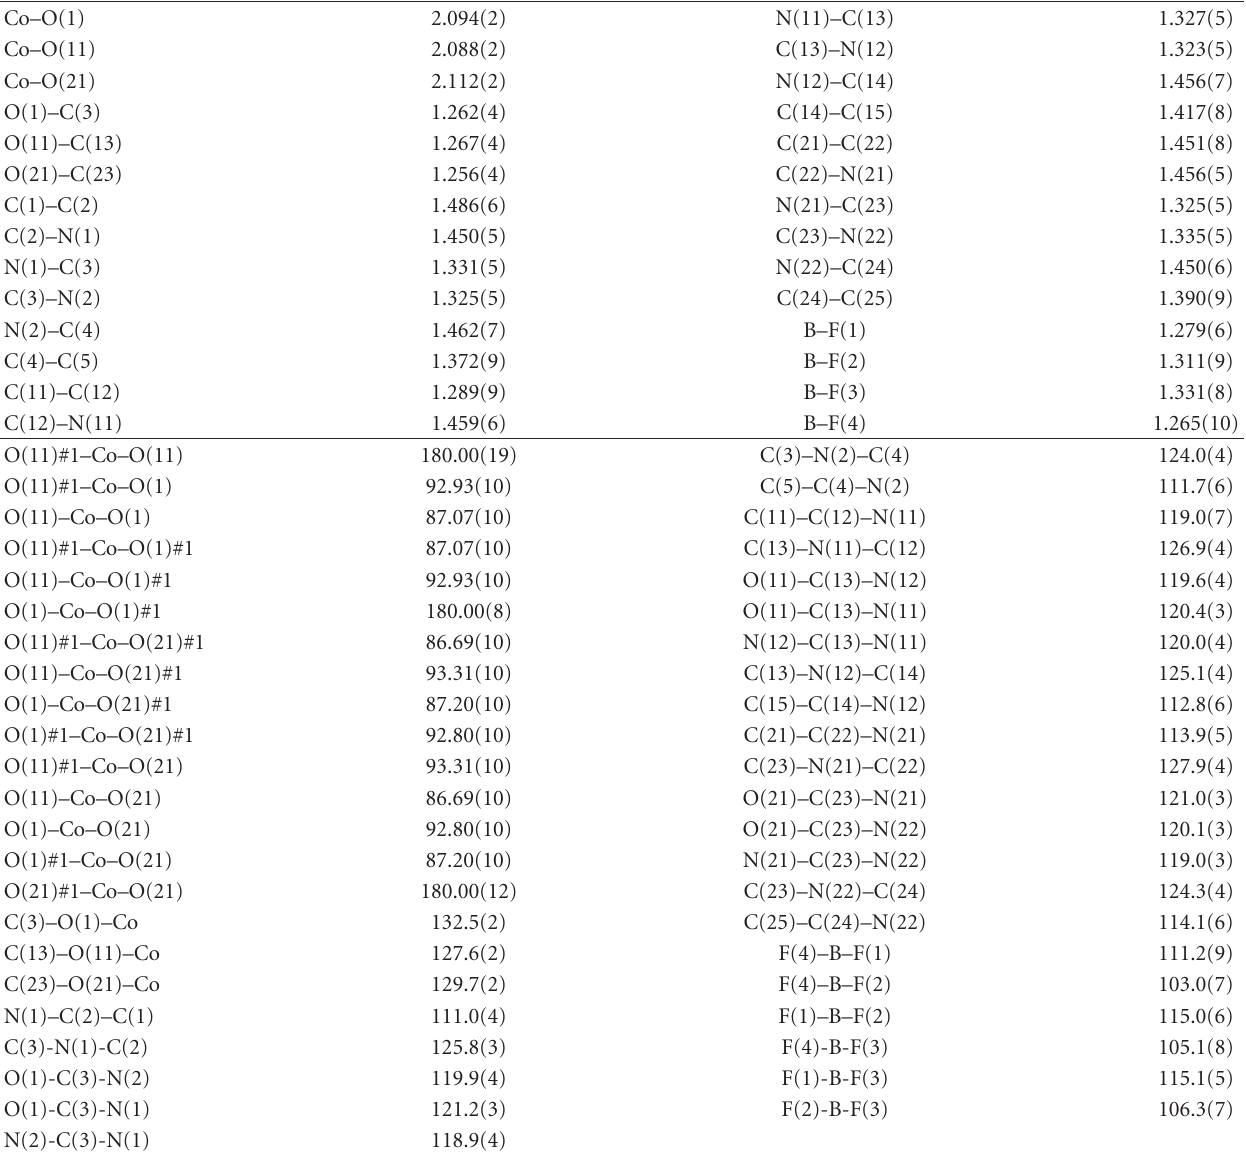
Table 2: Selected bond lengths (˚A) and angles ( ◦ ) for 1